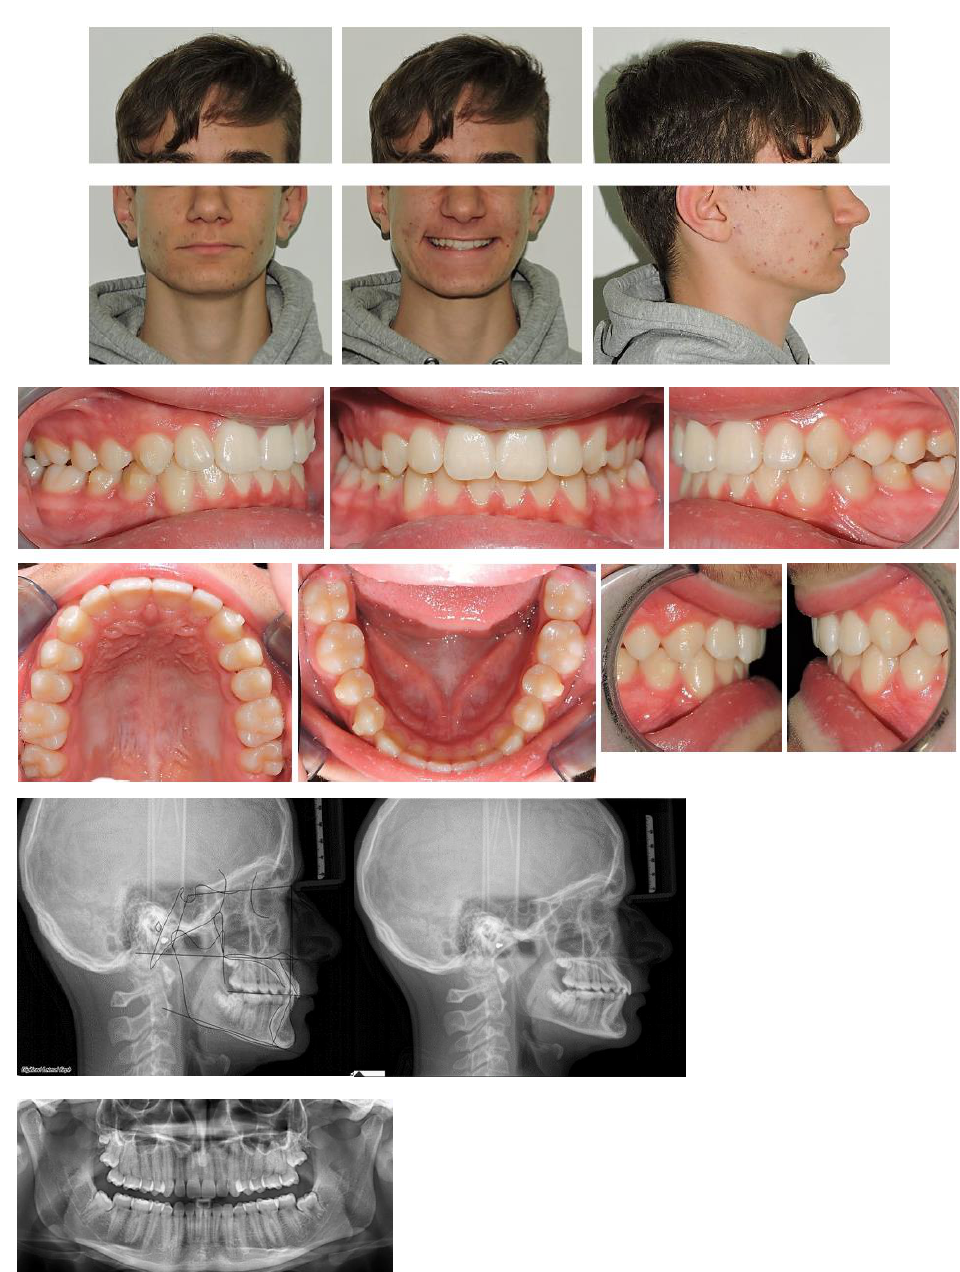
Figure 4. Post-treatment intraoral, extraoral photographs and radiographic examination.